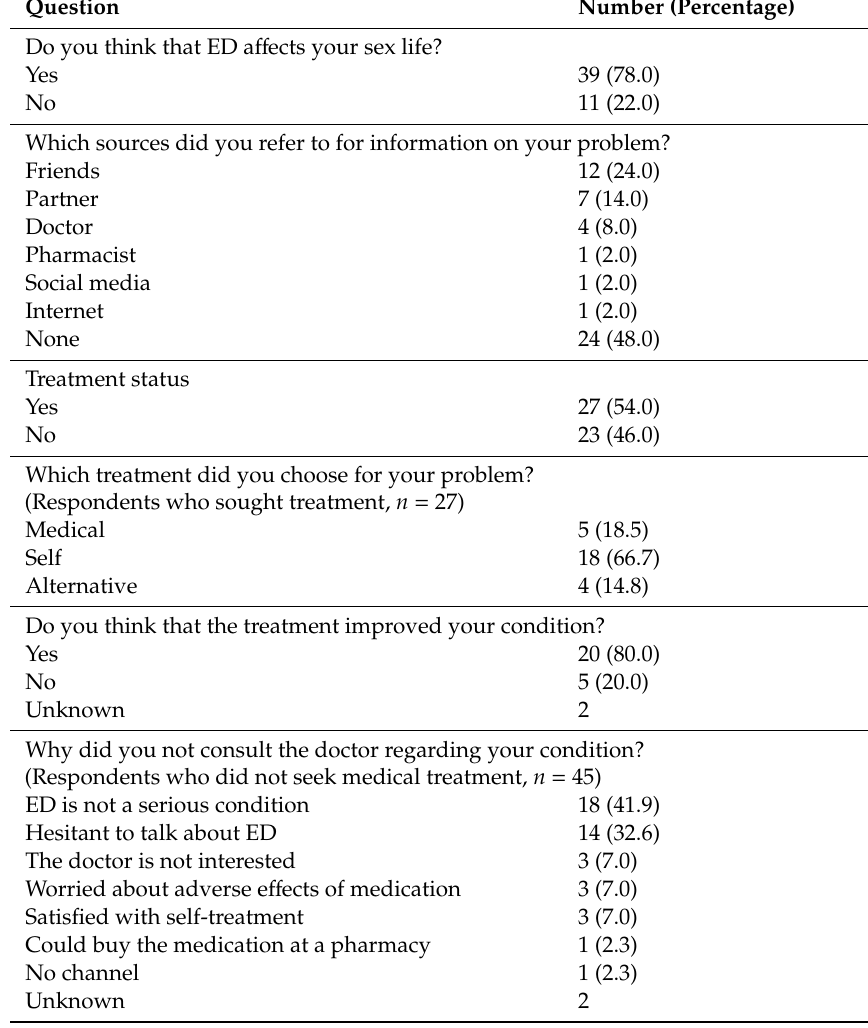
Table 1. The health-seeking behavior for erectile dysfunction (ED) among methadone maintenance treatment (MMT) patients ( n =